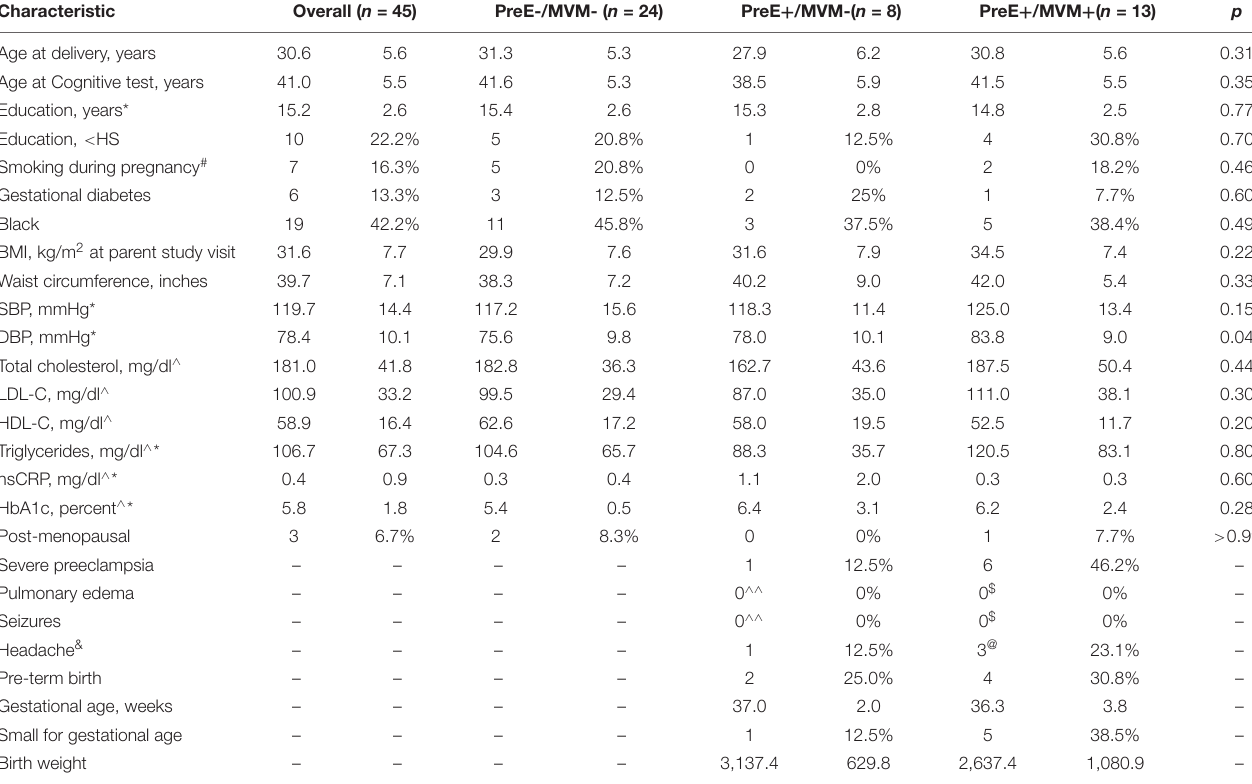
TABLE 1 | Characteristics of study participants overall and by preeclampsia and maternal vascular malperfusion status.